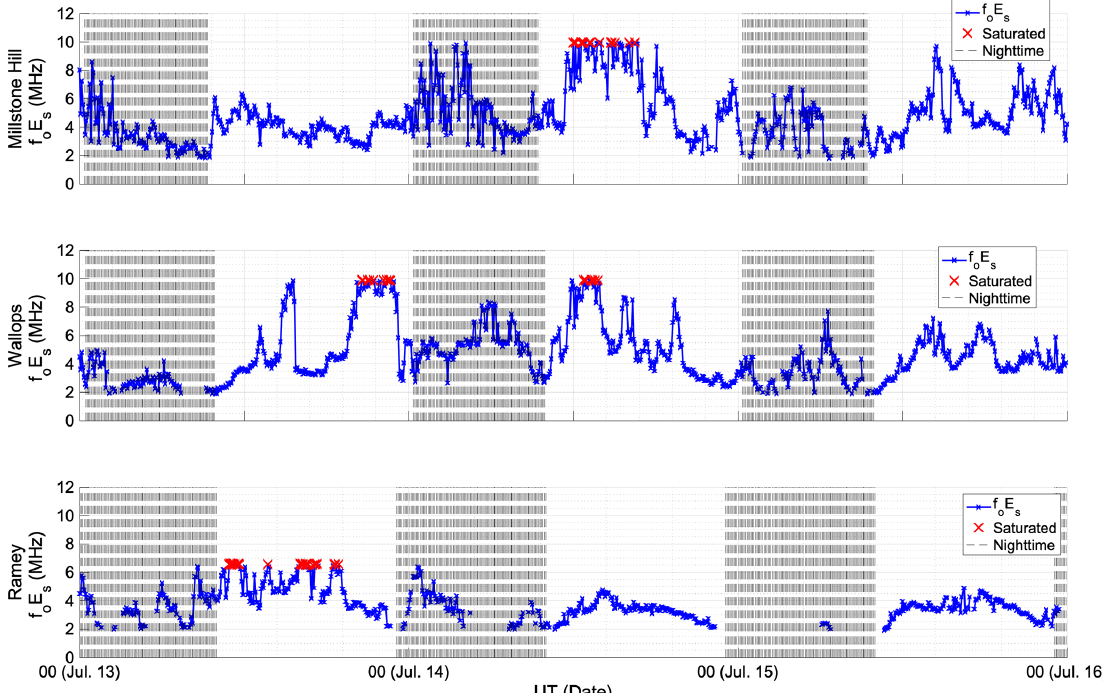
Figure 6. Autoscaled sporadic E data from the Millstone Hill, Wallops, and Ramey Digisondes. Saturated measurements where f o E s ex- ceeded the ionosonde’s frequency range are shown in red. Local nighttime is indicated by black dashed lines.